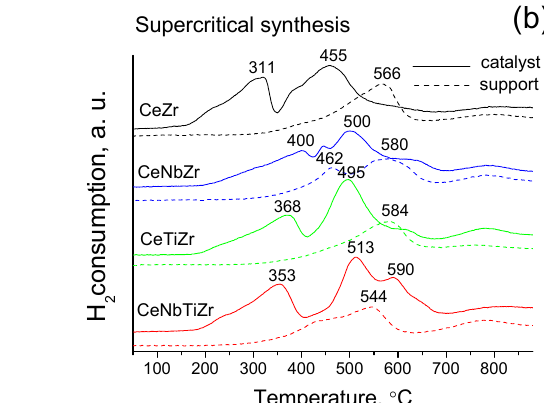
Figure 10. HAADF-STEM image with EDX analysis of catalyst Ni-CeTiNbZr prepared by citrate route.